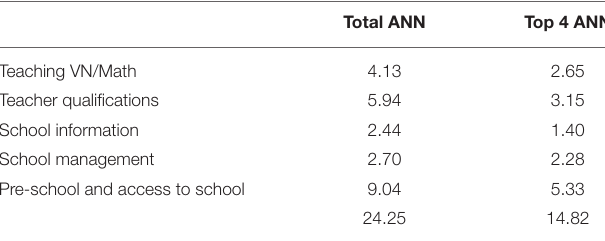
TABLE 7 | Total % predictive weights for the top 4 predictors in selected